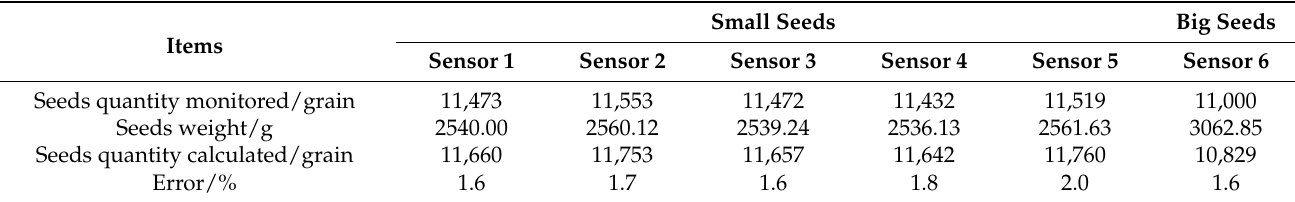
Table 1. Monitoring data for soybeans with different diameters.